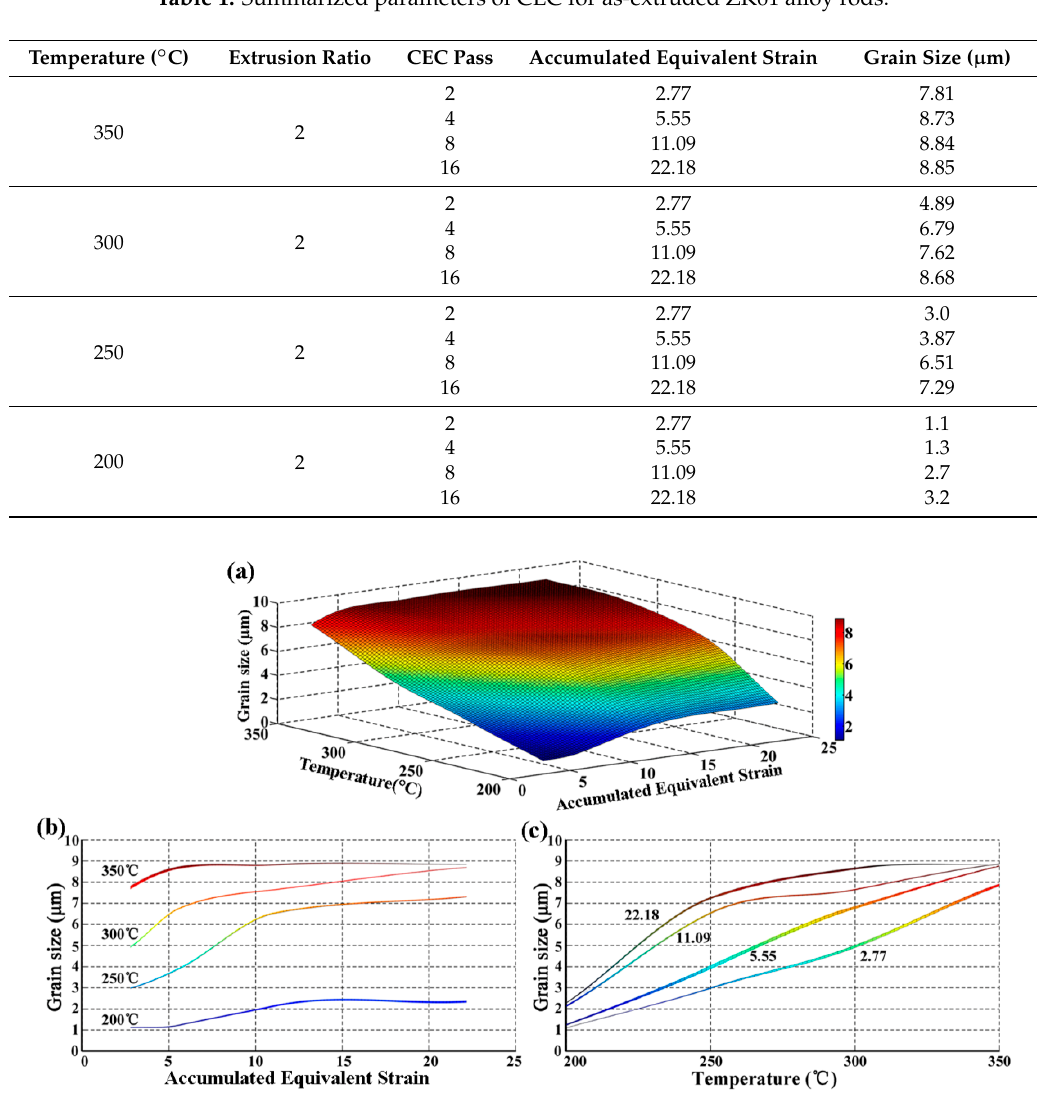
Figure 3. Three dimensional grain size distributions of CECed ZK61 alloy rods at different temperature and accumulated equivalent strains. ( a ) Three-dimensional (3D) diagram of grain sizes; ( b ) grain size curve of same temperature and different accumulated strains; and ( c ) grain size curve of same accumulated strains and different temperature.